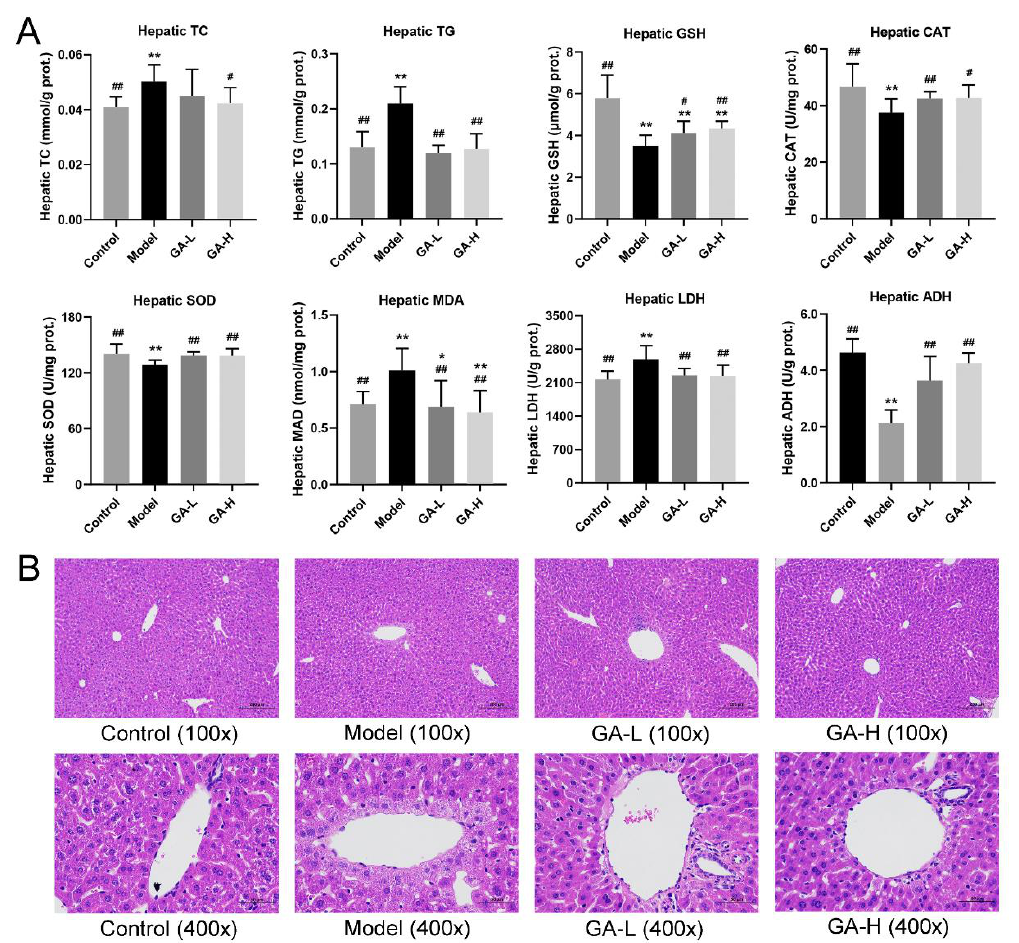
Figure 3. Effects of GA intervention on the liver biochemical parameters (TC, TG, GSH, CAT, SOD, MDA, LDH and ADH) ( A ) and liver histopathological features ( B ) in mice with excessive alcohol consumption. Values were expressed as mean ± SD, and ## p < 0.01 and # p < 0.05, versus the model group; ** p < 0.01 and * p < 0.05, versus the control group.